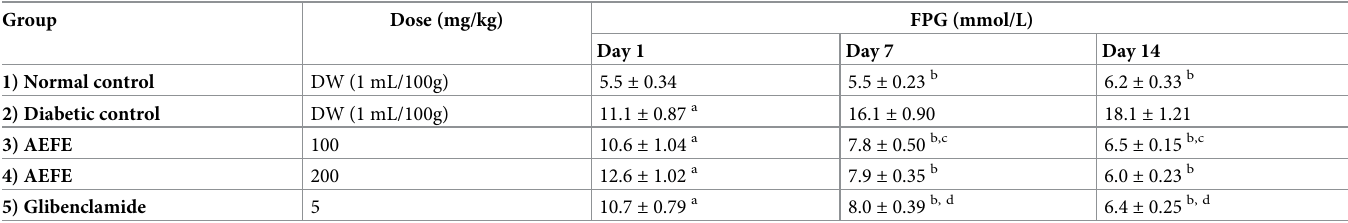
Table 6. Effect of standardized AEFE on fasting plasma glucose. Group